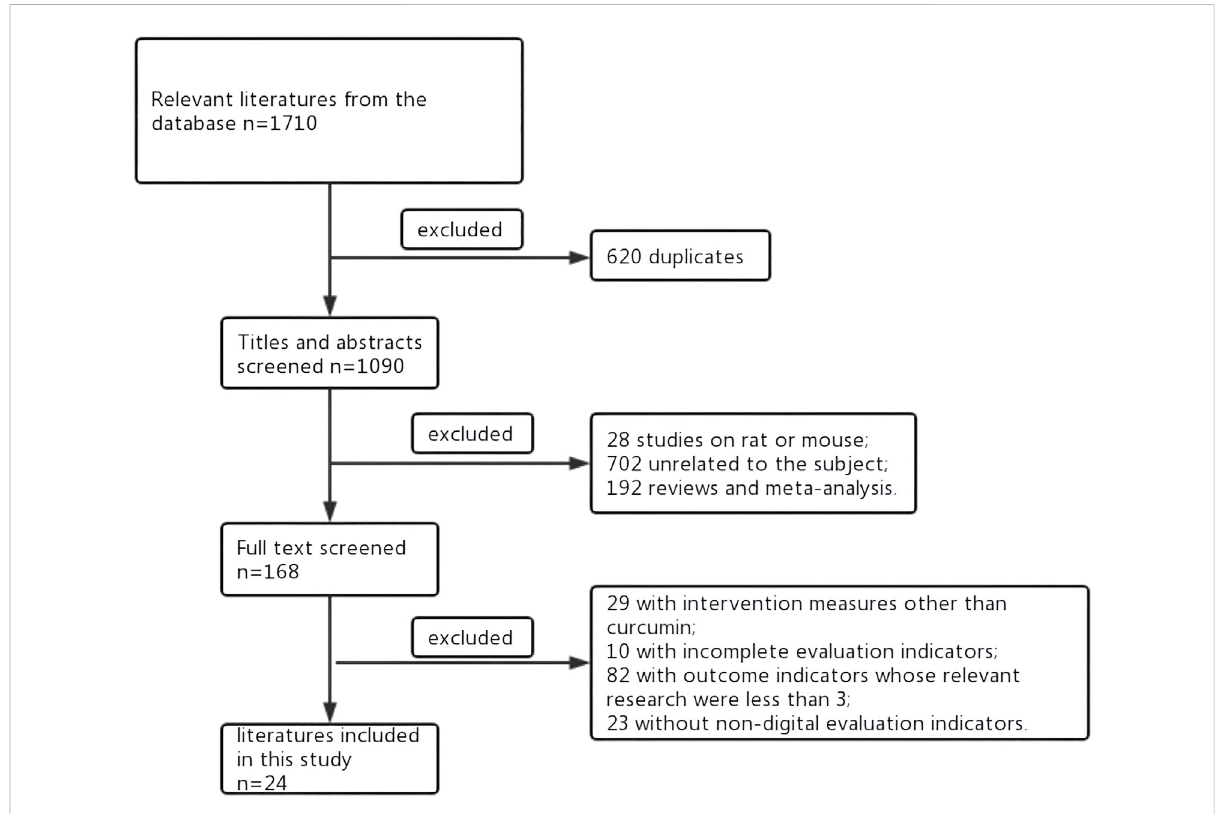
FIGURE 1 Document retrieval fl ow